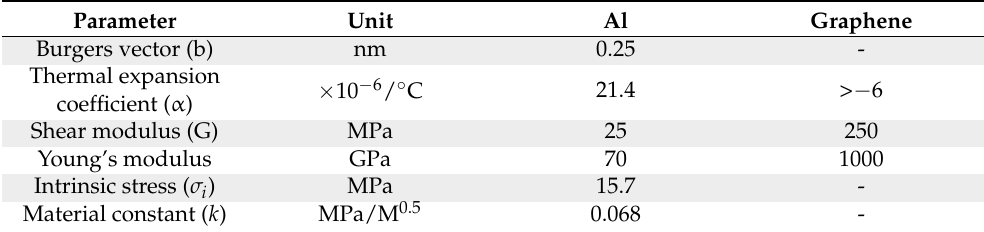
Table 4. Parameters used for calculating strengthening contributions